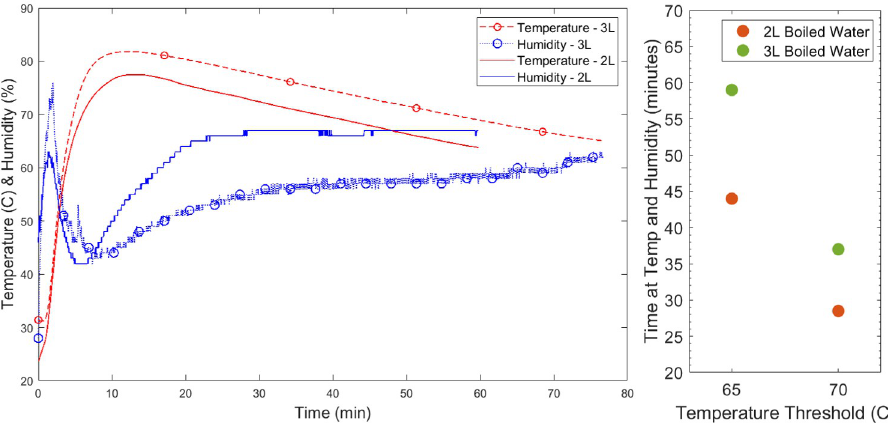
Fig 5. a. (left): Temperature and humidity inside the container over a single long cycle when placed in a vessel with 2L boiled water (solid lines) and 3L boiled water (dotted lines with circular markers). b (right): Time spent simultaneously above both humidity (50%) and temperature (65 & 70 ˚C) thresholds for 2L and 3L boiled water volumes.